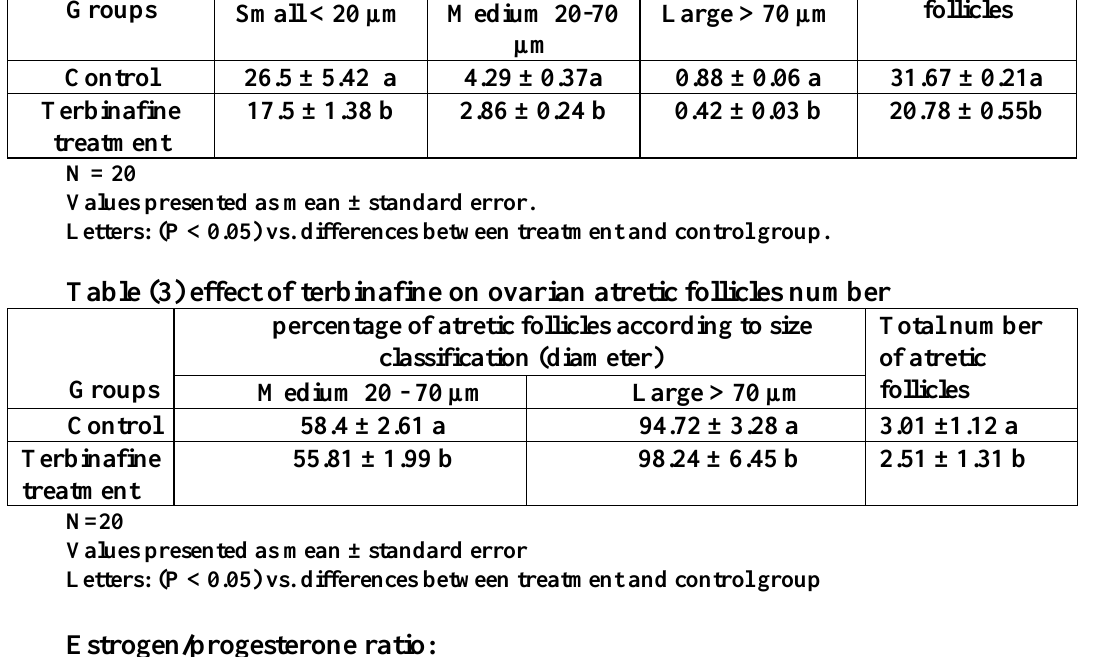
Table (2) effect of terbinafine on ovarian follicular numbers Groups